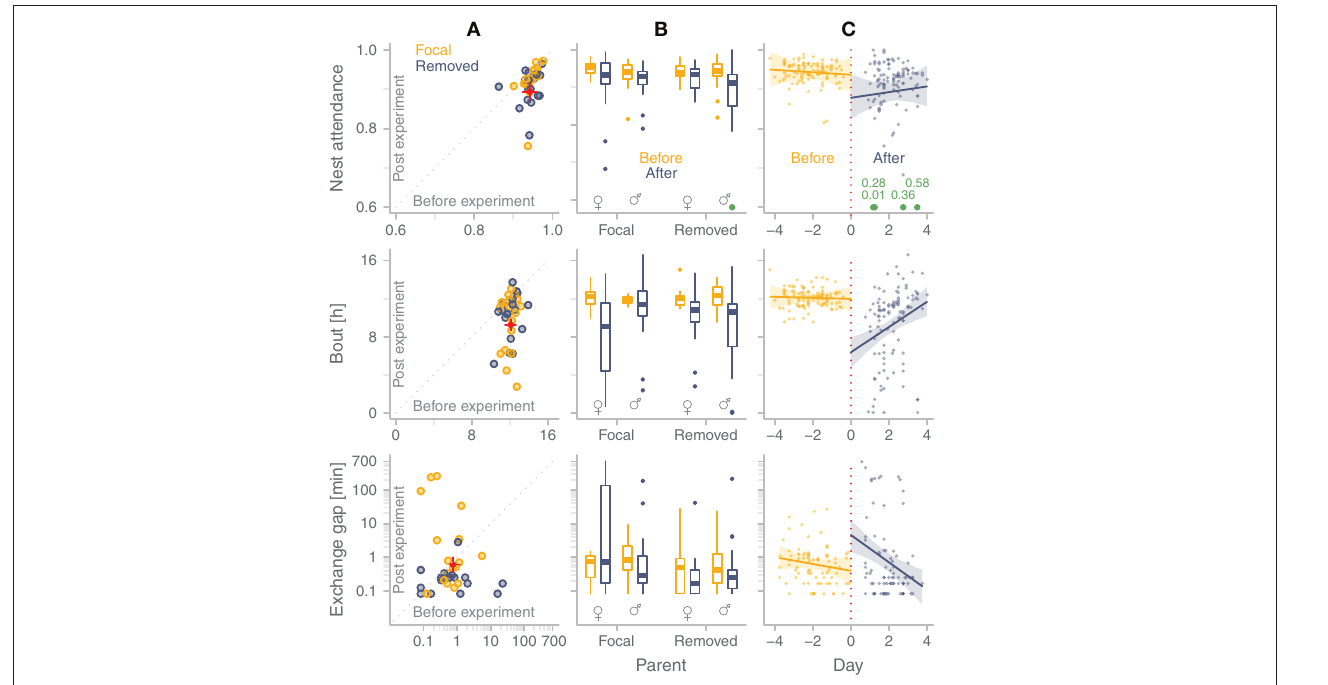
FIGURE 6 | Differences in quality of incubation before and after the experimental period. (A) Median nest attendance, median bout length, and median non-zero exchange gap duration for each individual in the period before and after the experiment. Dots represent medians for focal parents (yellow) and for removed parents (blue-gray; N attendance and N bout = 36 individuals with before and after-treatment data, N gap = 33 individuals with before and after-treatment gaps, 3 individuals had no gaps either in before, in after-treatment or in both). Red dots with bars indicate model predictions with 95%CI (Tables S4, S5, “simple model” in Bulla, 2019). (B) Comparison of nest attendance, bout length, and exchange-gap length between the period before (yellow) and after (blue-gray) the experiment for the focal and the removed parent and for each sex separately ( N attendance and N bout = 214 bouts, N gap = 164 exchange gaps). Box plots depict median (horizontal line inside the box), the 25th and 75th percentiles (box), the 25th and 75th percentiles ± 1.5 times the interquartile range or the minimum/maximum value, whichever is smaller (bars), and the outliers (dots). For nest attendance, the green dot represents four outliers (described in C ). (C) Temporal changes in nest attendance, bout or gap length of focal and removed individuals (combined) in the period before (yellow, negative values) and after the experiment (blue-gray, positive values). Dots represent individual observations and lines with shaded areas indicate model predictions with 95%CI (Tables S4, S5, “day model” in Bulla, 2019). See (B) for sample sizes. The red dotted line indicates the day when one of the parents was removed. In the nest attendance graph, four values are outside the range of the y-axis; these are indicated in green with their actual nest attendance value. In case of nest attendance, the model including day was slightly less supported than the simple model. In case of bout length and exchange gap duration, the model including day was much more supported than the simple model. For exchange-gap duration, the model that also contained parent type (focal or removed) was even more likely (Tables S4, S5 in Bulla,